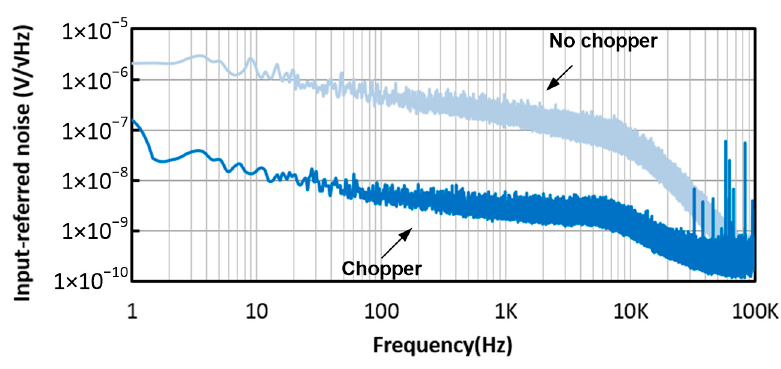
Figure 15. The measured input-referred noise of the chopper IA before and after the chopper modulator is activated.